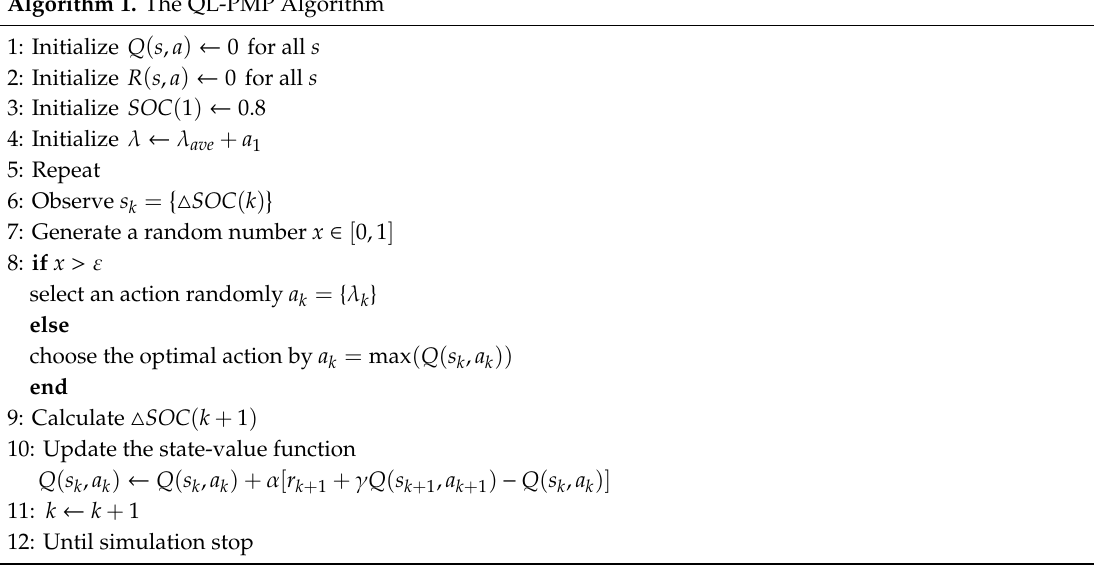
Algorithm 1. The QL-PMP Algorithm